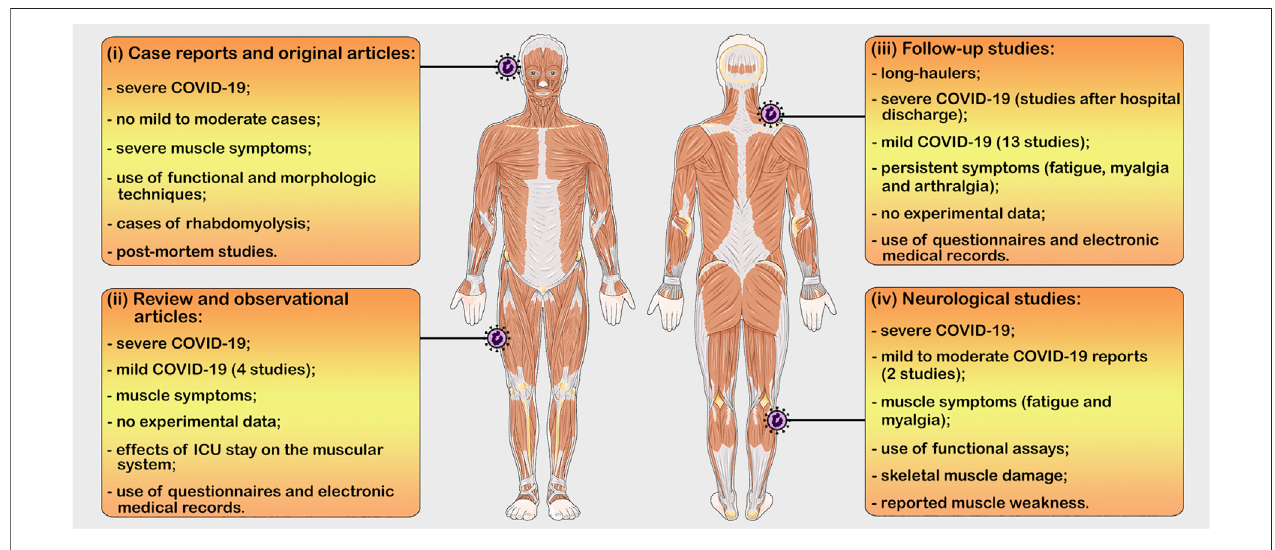
FIGURE 4 | The four main types of studies comprising COVID-19 and the skeletal muscle. (i) case reports and original articles of hospitalized individuals (severe COVID-19; functional and morphologic techniques); (ii) Review and observational articles citing only the musculoskeletal symptoms (mild and severe COVID-19; no experimental data); (iii) Follow-up studies of patients with persistent muscle symptoms (mild and severe COVID-19; no experimental data); and (iv) Neurological studies that includes musculoskeletal symptoms (mild to moderate and severe COVID-19; functional assays). ICU = intensive care unit. Figure produced using Servier Medical Art